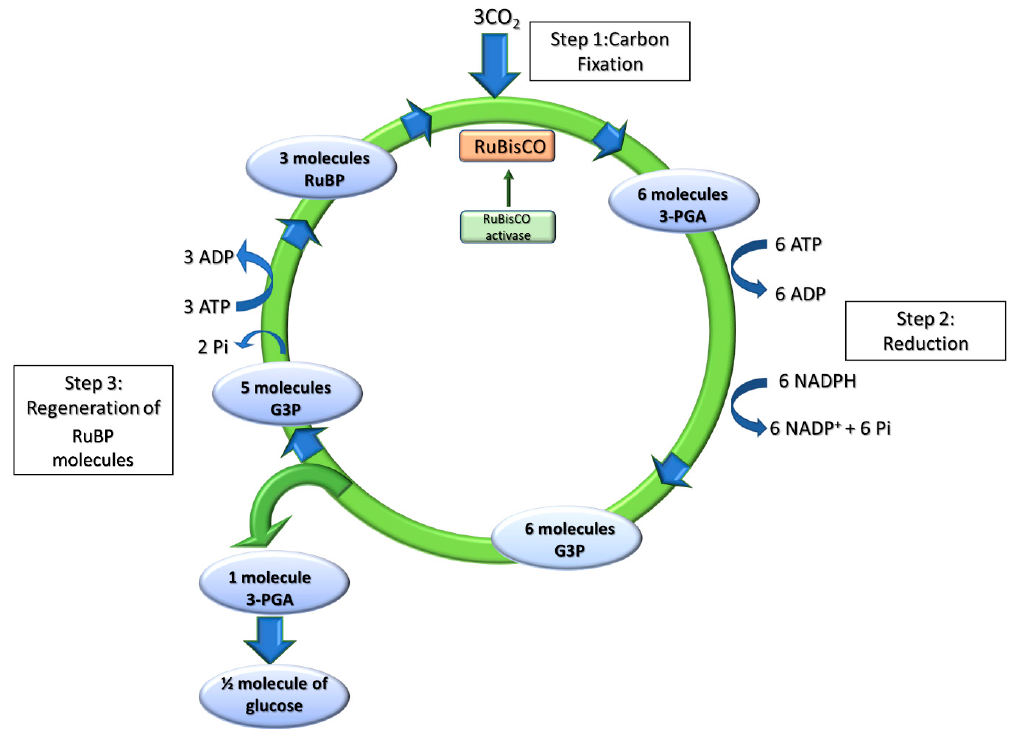
Figure 3. The Calvin–Benson–Bassham cycle (CBBc) reactions. The CBBc has three stages. In stage 1,